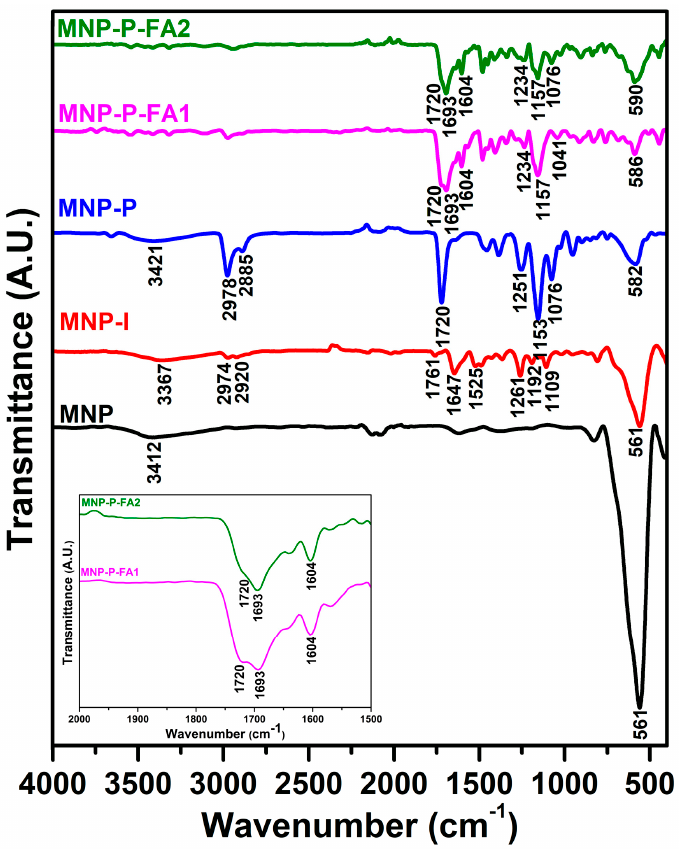
Figure 1. FTIR spectra of MNP (black), MNP-I (red), MNP-P (blue), MNP-P-FA1 (magenta), and MNP-P-FA2 (green). Insert represents the amplified area exhibited by the amide band of MNP-P-FA2 (green). A.U. – arbitrary units.